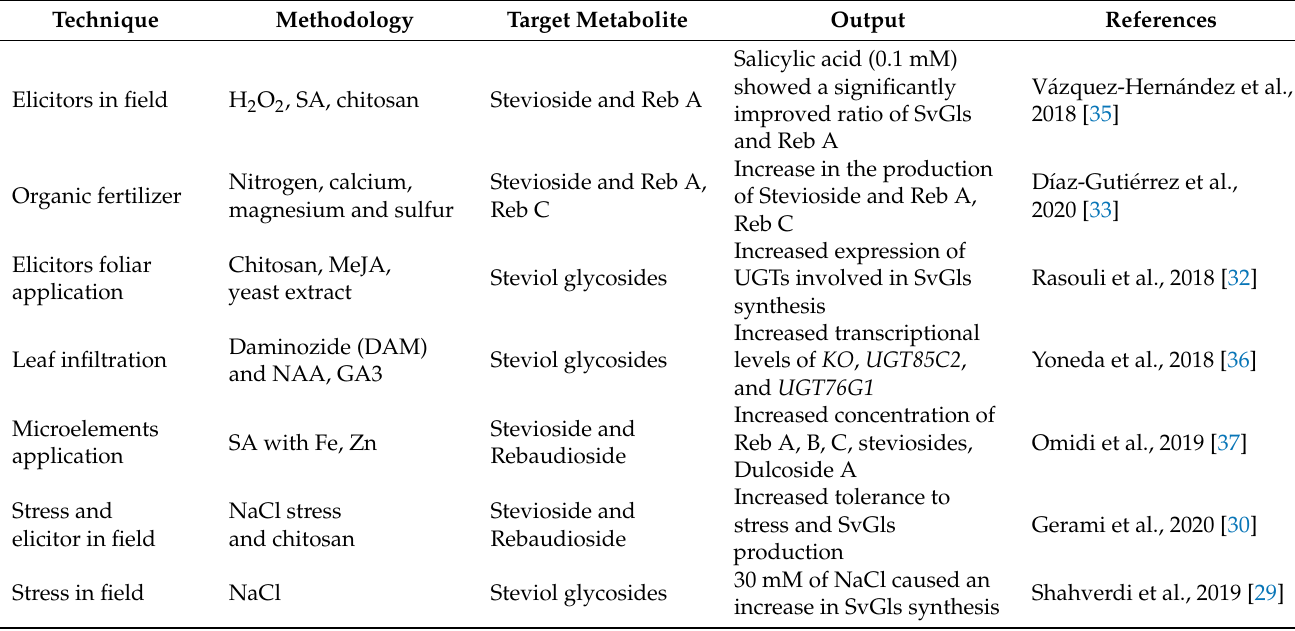
Table 1. Outline of the conventional (physical and chemical) approaches to enhance steviol glycosides concentration in S. rebaudiana